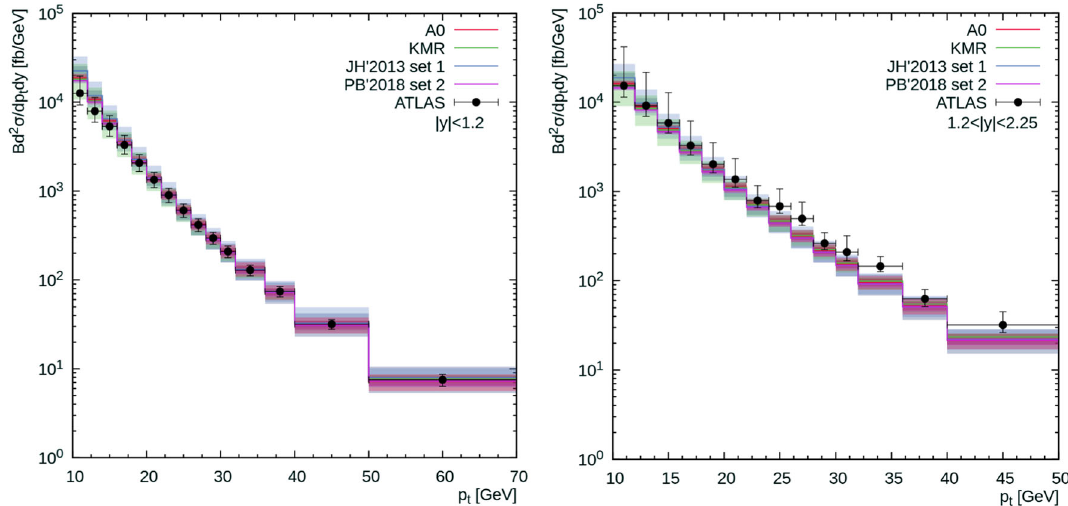
Fig. 2 Transverse momentum distribution of inclusive ϒ( 2 S ) produc- √ s = 7 TeV in the different rapidity regions. The red, tion calculated at green,blueandviolethistogramscorrespondtothepredictionsobtained